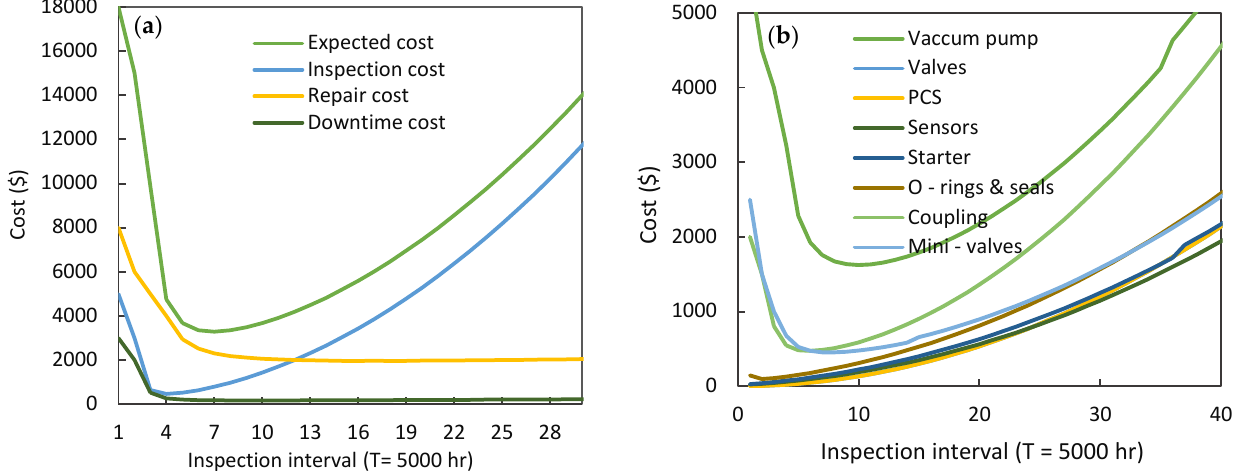
Figure 10. The optimal maintenance intervals for the ( a ) whole system and ( b ) critical components.